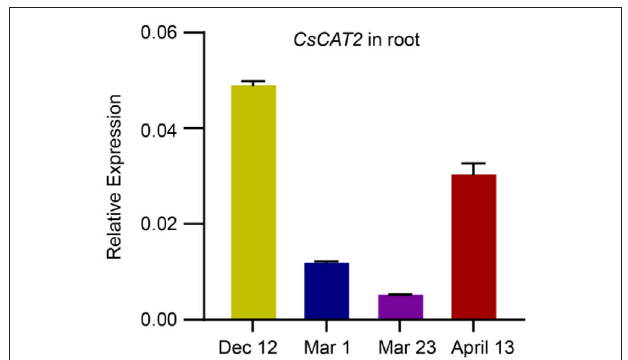
FIGURE 2 | Seasonal expression of CsCAT2 in the root of tea plant cultivar “Shuchazao” tea cultivar. The expression of CsCAT2 in the root at four time points, December 12 (Dec 12), March 1 (Mar 1), March 23 (Mar 23), and April 13, was examined by qRT-PCR. The data were calculated using the 2 − 1 ct method and represented as mean ± SD ( n = 3) with CsGAPDH as the internal